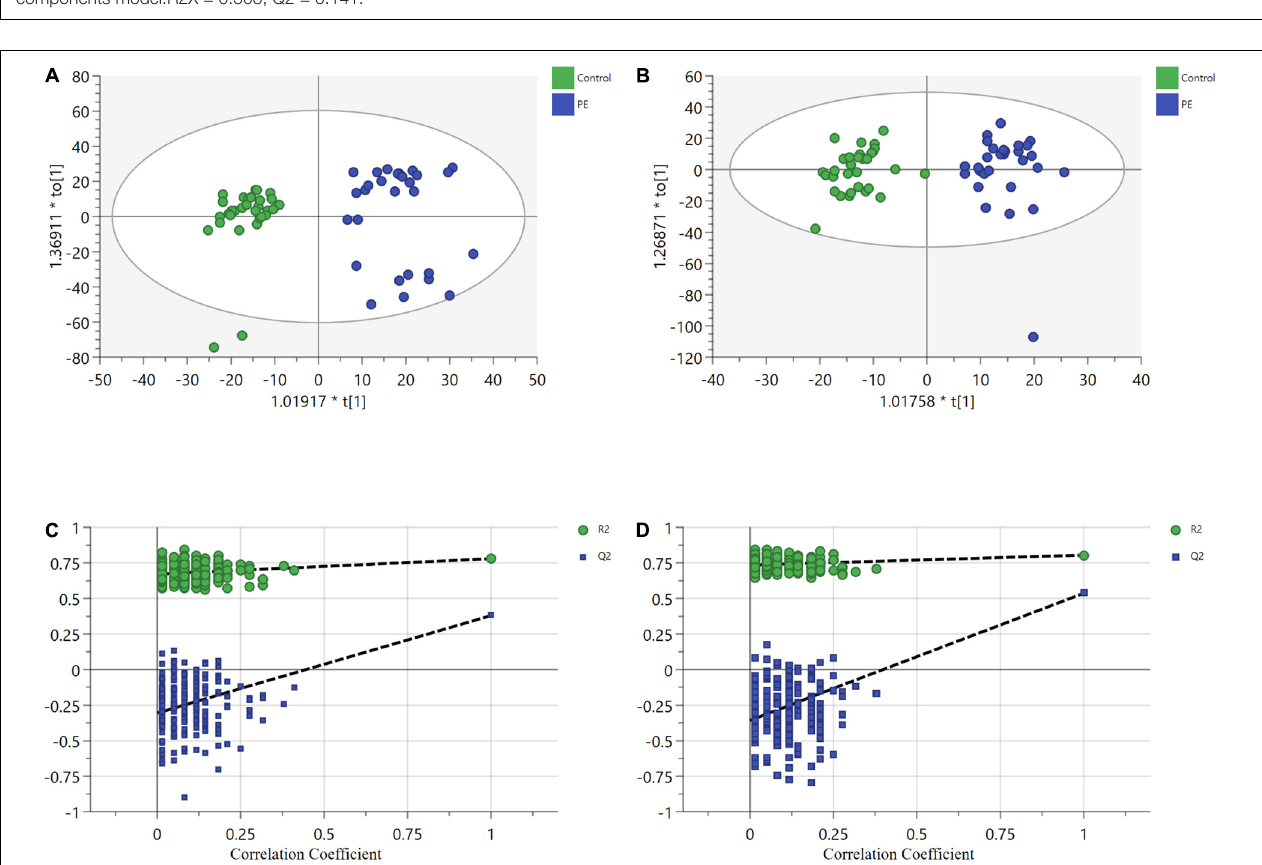
FIGURE 2 | Orthogonal partial least squares discriminant analysis (OPLS-DA) plots show significant separation of metabolic profiles between PE (in blue) and non-PE (in green) for (a1,b1) . (A) UHPLC-QE-MS (+) OPLS-DA model, R2X = 0.209, R2Y = 0.78, Q2 = 0.441. (B) UHPLC-QE-MS(–) OPLS-DA model, R2X = 0.175, R2Y = 0.805, Q2 = 0.544. (C) A permutation test of UHPLC-QE-MS (+) model. The Y -axis intercepts were: R2Y (0, 0.6), Q2(0, –0.89). (D) A permutation test of UHPLC-QE-MS(–) model. The Y -axis intercepts were: R2Y (0, 0.7), Q2 (0,